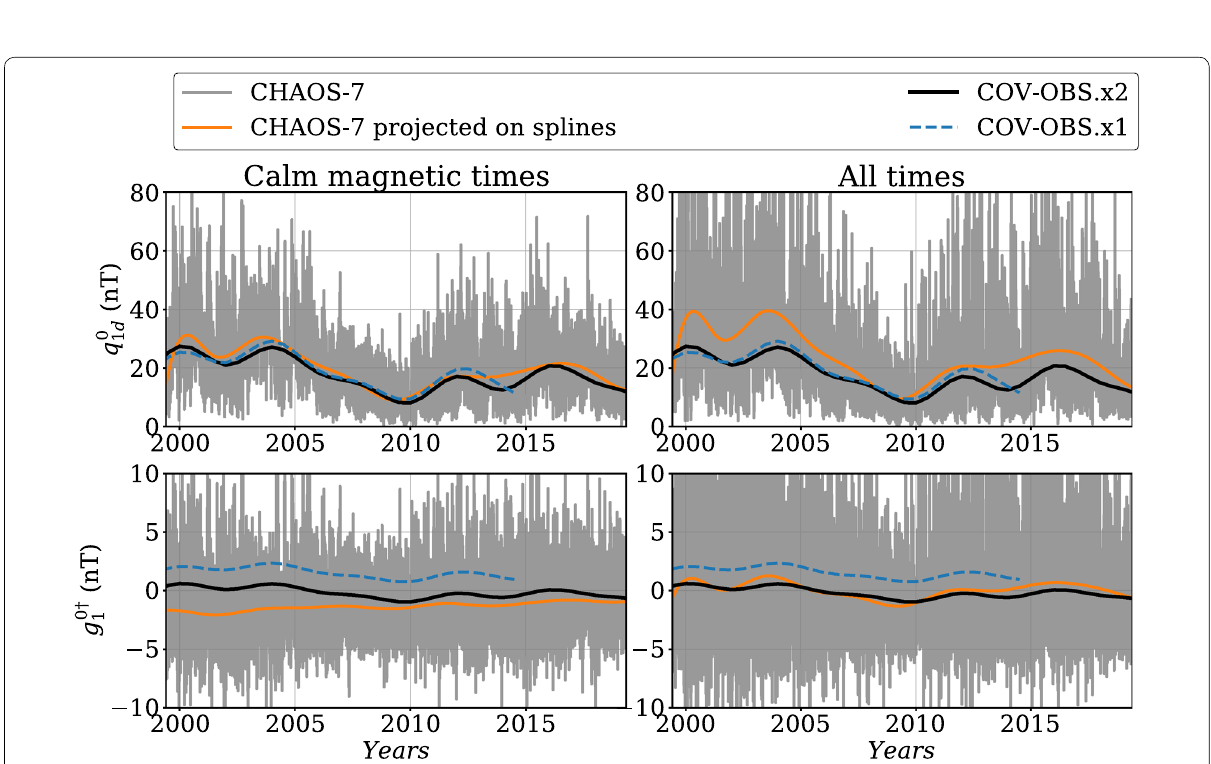
Fig. 10 Time evolution of the external dipole field coefficient in dipole coordinates (top: q 0 1 d ) and induced dipole field coefficient in geocentric coordinates (bottom: g 0† 1 ) for COV-OBS.x2 (black), compared with the previous edition COV-OBS.x1 (dashed blue), superimposed with the corresponding estimate from CHAOS-7 (gray, selected over calm magnetic times on the left column (see text for details) and for all times in the right column) and its projection onto splines with knots 2-year apart